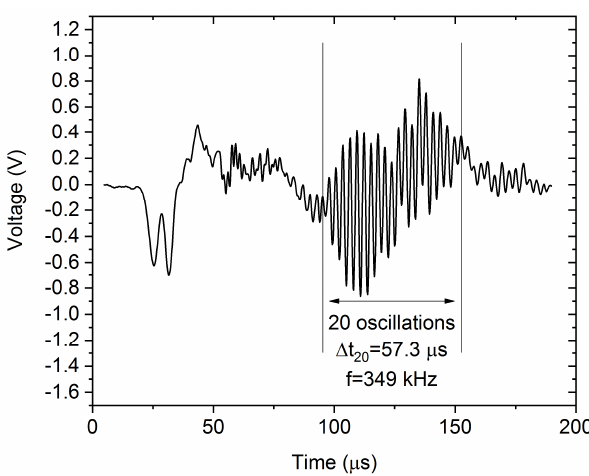
Figure 7. Characteristic avalanche of Cluster 3. The ringing is the most spectacular at the selected part of the avalanches, resulting in ringing of 349 kHz frequency, as was expected from the PSD curve of Cluster 3.